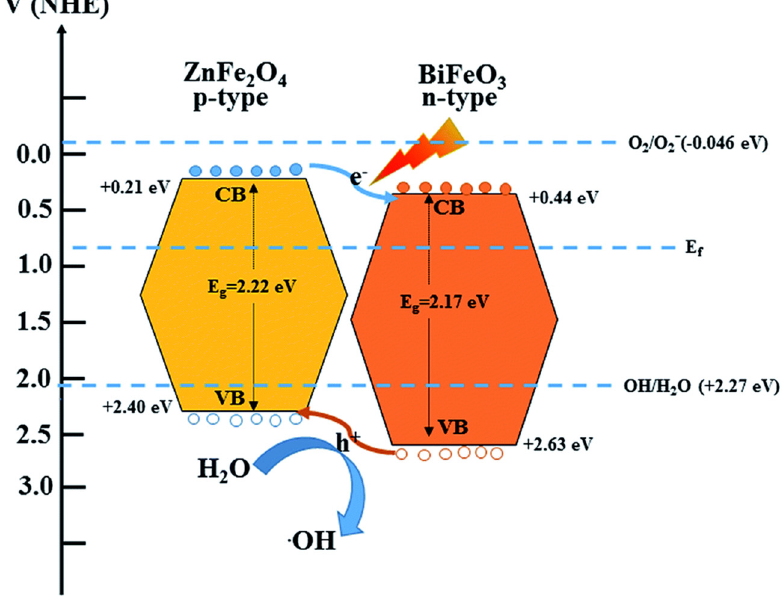
Figure 7. The schematic illustration of charge carriers’ migration in BiFeO 3 ‐ ZnFe 2 O 4 composite. Reprinted with permission from [119]. Copyright (2018) Creative Commons Attribution.